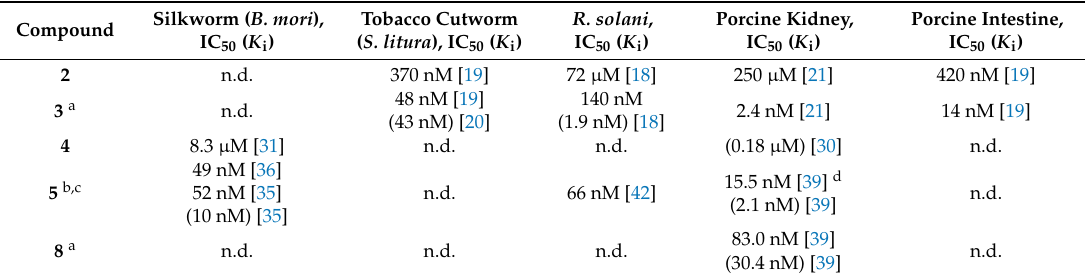
Table 1. Inhibition of insect trehalases from silkworm ( B. mori ) and tobacco cutworm ( S. litura ), fungi trehalase from R. solani , porcine kidney and porcine intestine trehalases by compounds 2 , 3 , 4 , 5 and 8 . Silkworm ( B. mori ), Tobacco Cutworm Compound IC 50 ( K i ) ( S. litura ), IC 50 ( K i